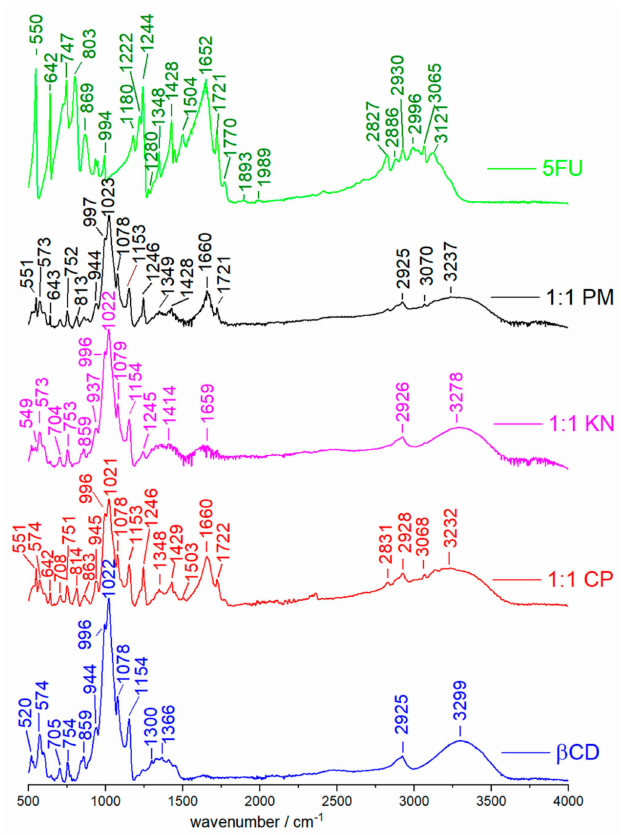
Figure 2. The ATR spectrum of 5-FU shows characteristic absorption bands in the range of 3121–2827 cm − 1 which are due to the hydrogen-bonded N-H group vibrations and the C-H stretching vibrations. The C = O, C-N and C = C vibrations appear as strong bands in the region of 1770–1280 cm − 1 , with the most intensive carbonyl stretch at 1652 cm − 1 . The C-F stretching band appears at 1244 cm − 1 . The bands in the fingerprint region are due to vibrations of the substituted pyrimidine ring (994–550 cm − 1 ). In agreement with the literature [60], the ATR spectrum of β -CD shows a broad and strong O-H band in the region of 3600–3000 cm − 1 and several narrower vibration bands in the region of 1500–1250 cm − 1 . The absorption band at 2925 cm − 1 is due to the stretching vibrations of aliphatic CH 2 groups. The most intensive band at 1022 cm − 1 is due to the C-O stretching vibration. Bands in the fingerprint region are due to ring vibrations (859–520 cm − 1